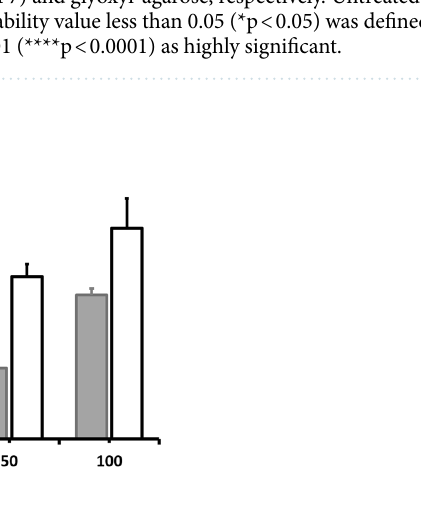
Figure 7. In vitro cytotoxicity study on fibroblast cells (10,000 cells/well) at 24, and 48 h after treatment with Glyoxyl-EGF10 at 10, 25, 50 and 100 ng/mL. Untreated cells have been used as negative control (ctr, 0